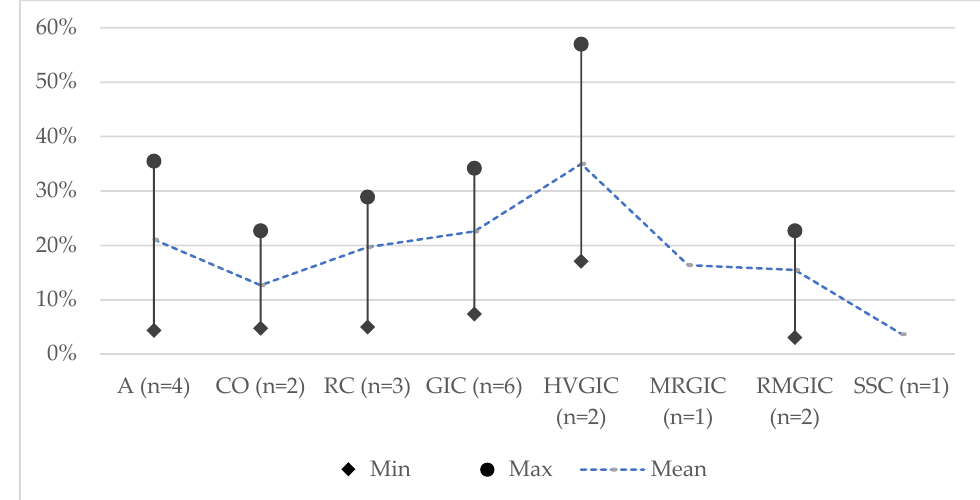
Figure 3. The failure rate of restorative materials at 36 months. Abbreviations: A: amalgam; CO: compomer; GIC: glass-ionomer cement; HVGIC: high-viscosity glass-ionomer cement; MRGIC: metal-reinforced glass-ionomer cement; RC: resin composite; RMGIC: resin-modified glass-ionomer cement; SSC: stainless steel crown; n : represents the number of reviews in which the efficacy of the specific material was assessed; Min: minimum value for failure rate; Max: maximum value for failure rate.